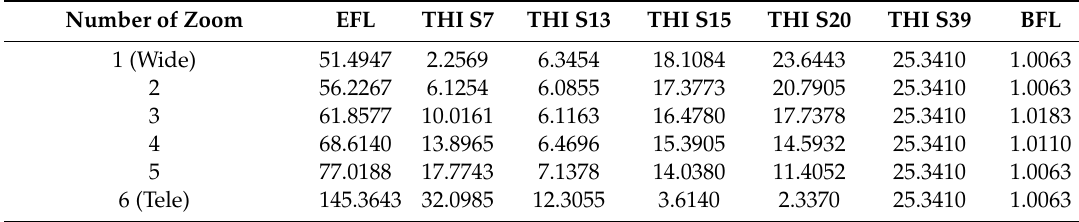
Table 9. Zoom data of the first example in KR10-2014-011186.